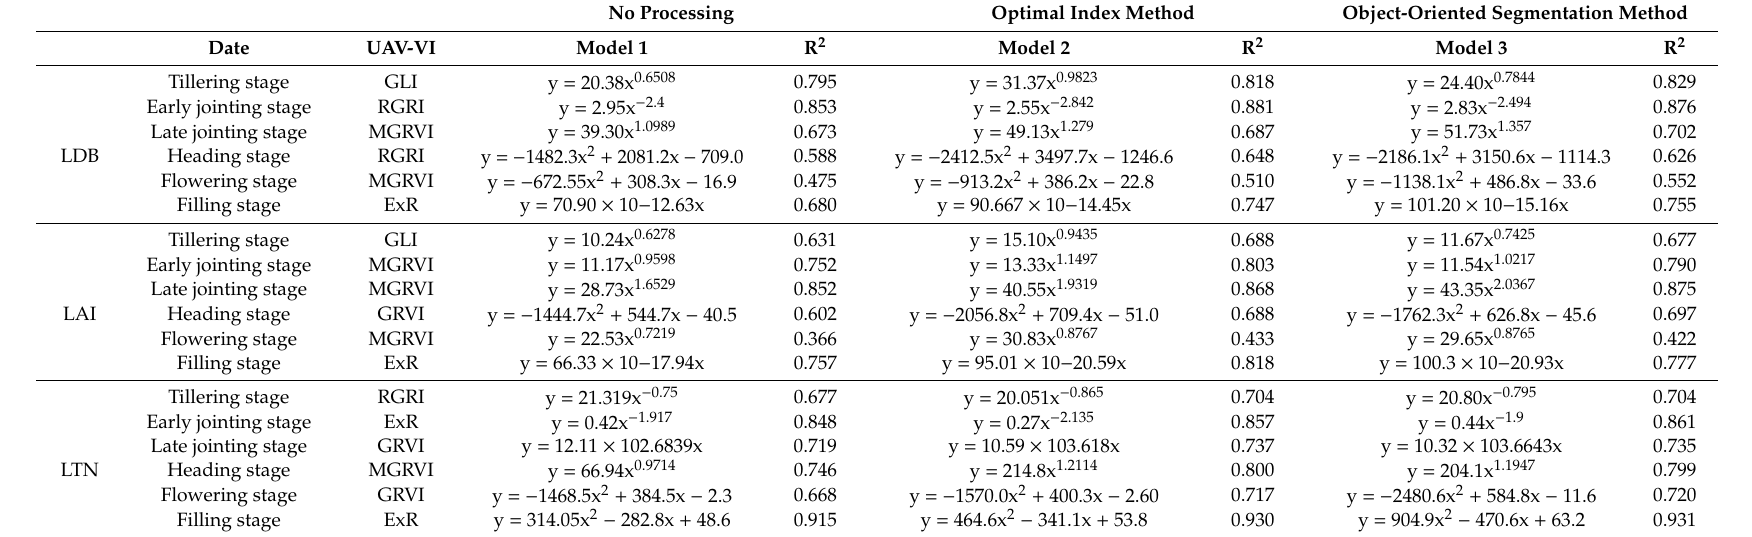
Table 6. Estimation model and accuracy comparison of key growth indicators and the optimal index under di ff erent